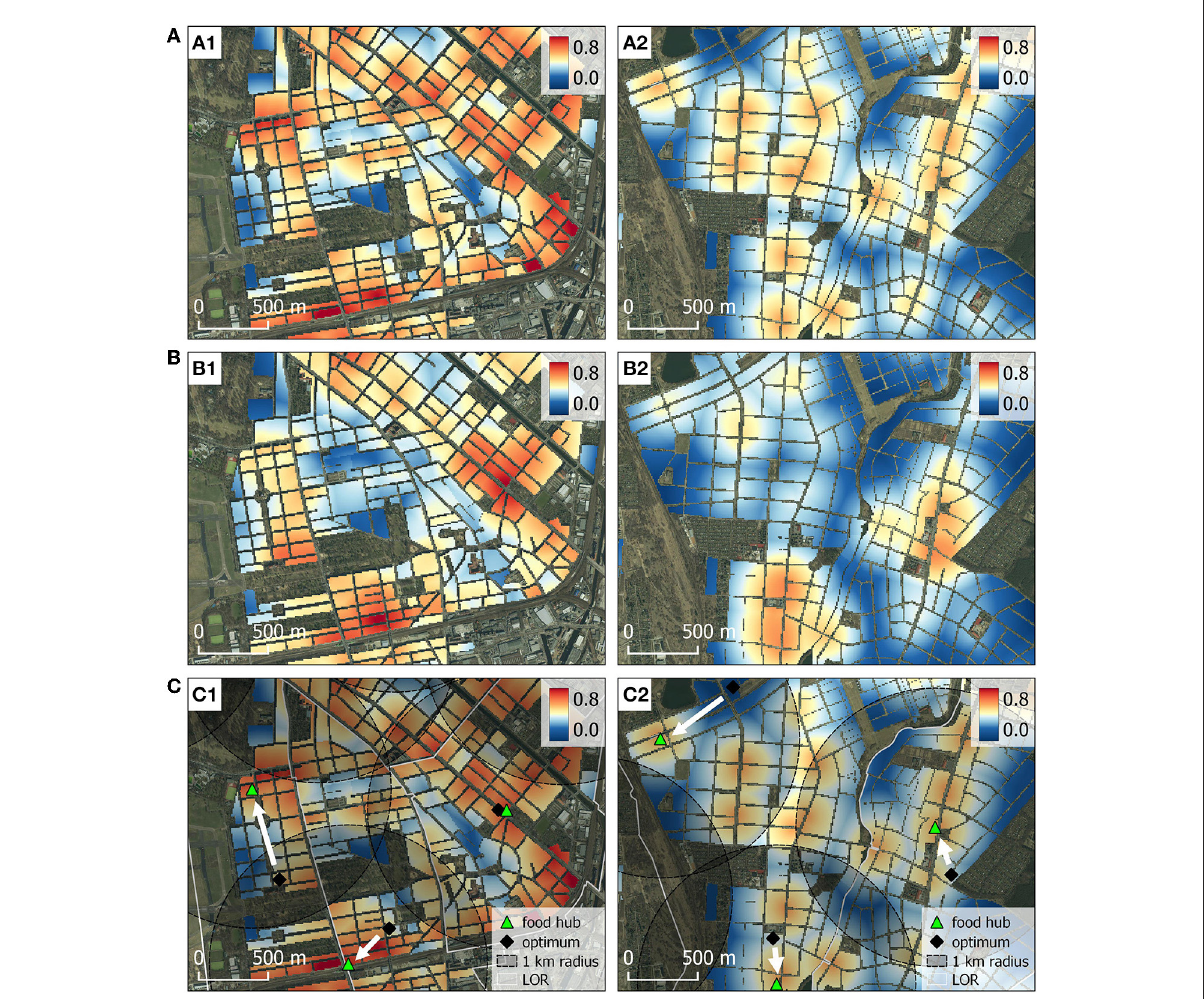
FIGURE3 Site-suitability for implementing FHs in two contrasting areas of Berlin (left: Neukölln, right: Mahrzahn-Hellersdorf). (A) Site-suitability without considering an optimal distribution, (B) site-suitability considering an optimal distribution and (C) reallocation of the optimum. The satellite image is provided by © MapTiler and © OpenStreetMap